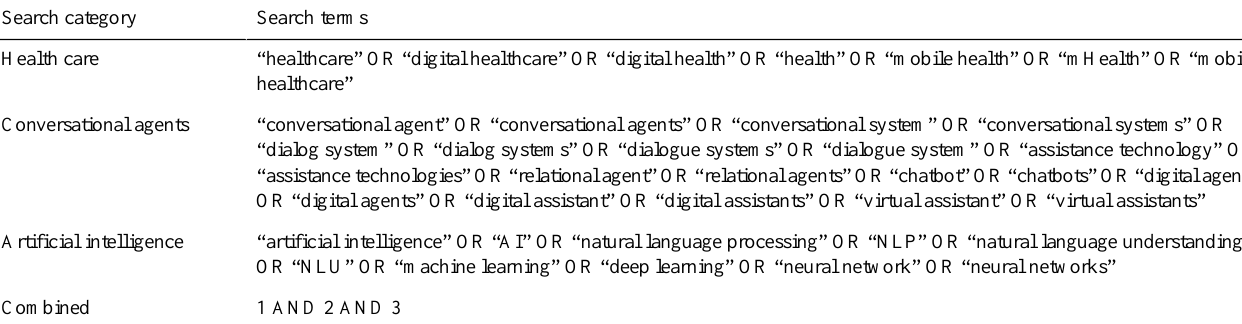
Table 1. The search strategy used in PubMed